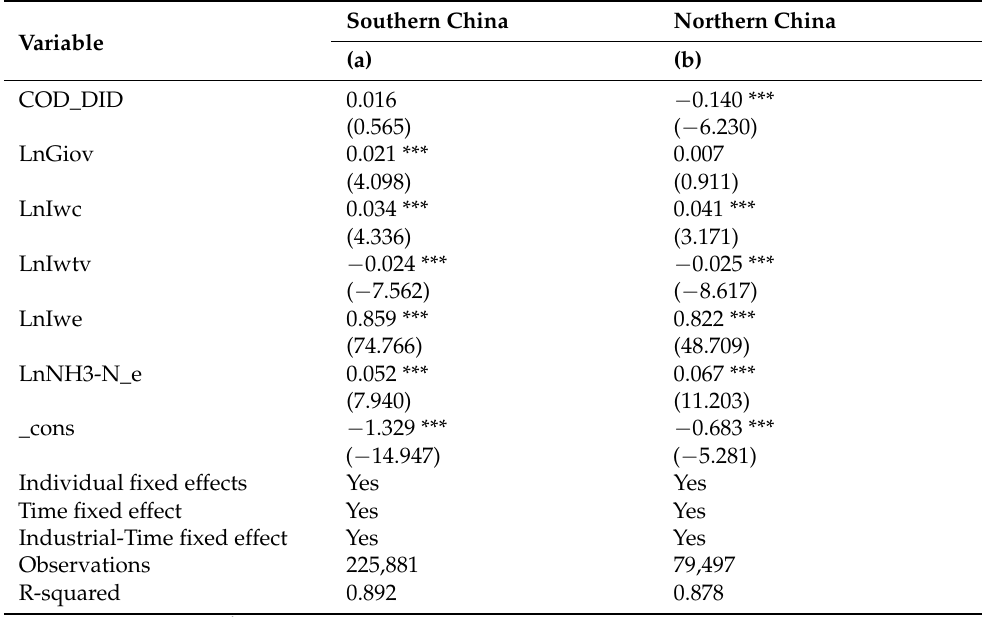
Table 7. Location heterogeneities of the impact of pollution fee